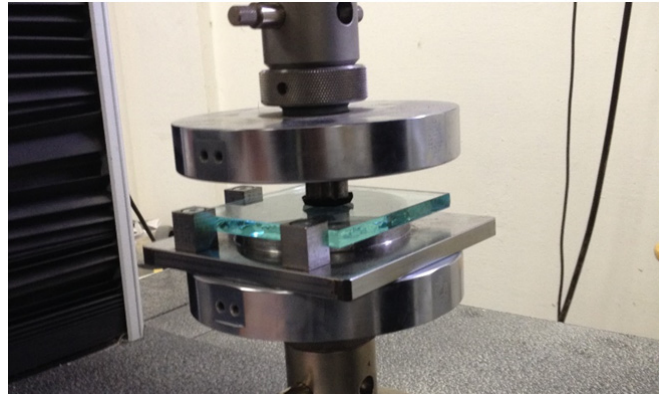
Fig. 5Method of test by coaxial double rings (CDR) - EN